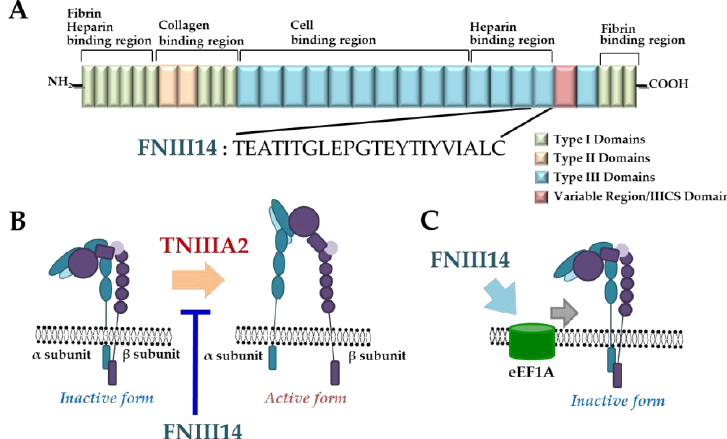
Figure 4. Plasma fibronectin-derived peptide FNIII14. ( A ) Schematic illustration of plasma fibronectin and amino acid sequence of antiadhesive peptide FNIII14. ( B ) Conformational shift of integrin by peptide FNIII14. ( C ) Eukaryotic elongation factor 1A (eEF1A) as a putative membrane receptor of peptide FNIII14.